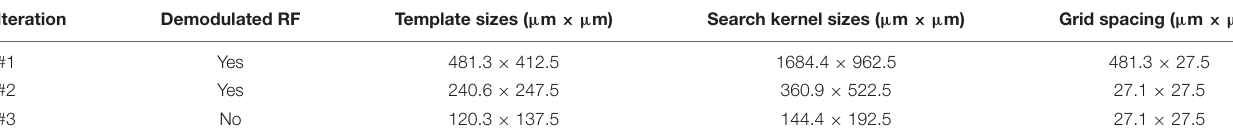
TABLE 1 | Coarse-to-fine displacement algorithm settings.